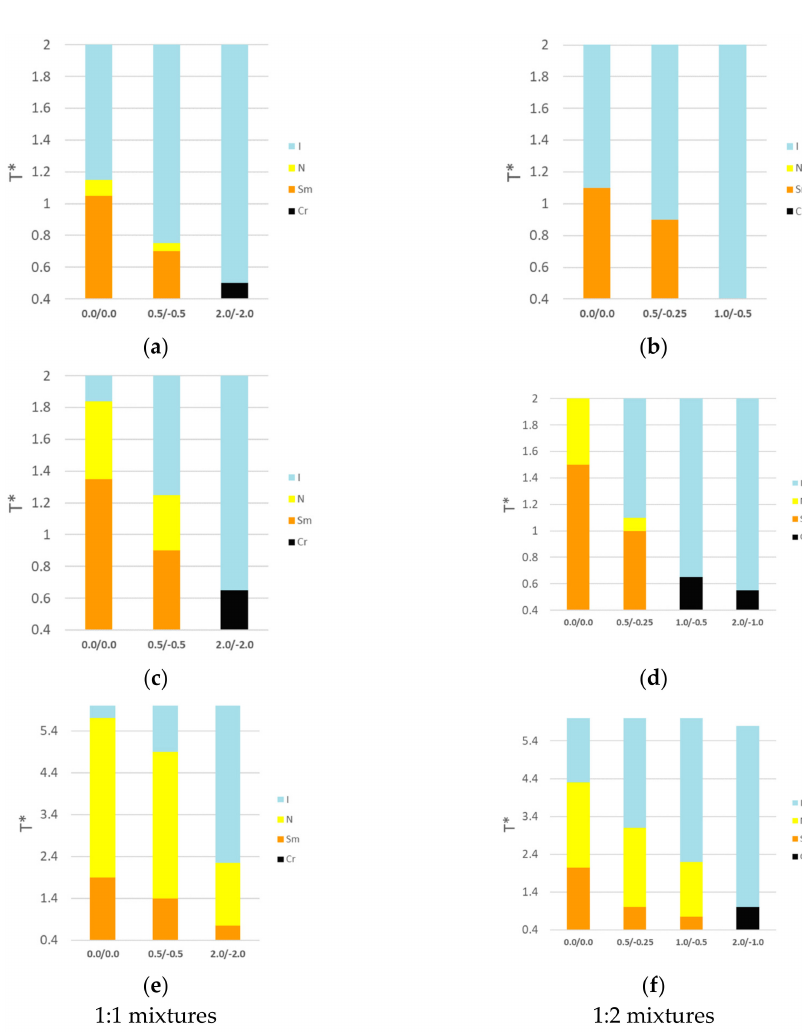
Figure 8. Temperature range of stability of the various systems investigated. ( a ): packing fraction η * = 0.371, GB:LJ = 1:1; ( b ) packing fraction η * = 0.371, GB:LJ = 1:2; ( c ): packing fraction η * = 0.428, GB:LJ = 1:1; ( d) packing fraction η * = 0.428, GB:LJ = 1:2; ( e ): packing fraction η * = 0.514, GB:LJ = 1:1; ( f ) packing fraction η * = 0.514, GB:LJ = 1:2. Note the different T * scale for the highest packing fraction ( e , f